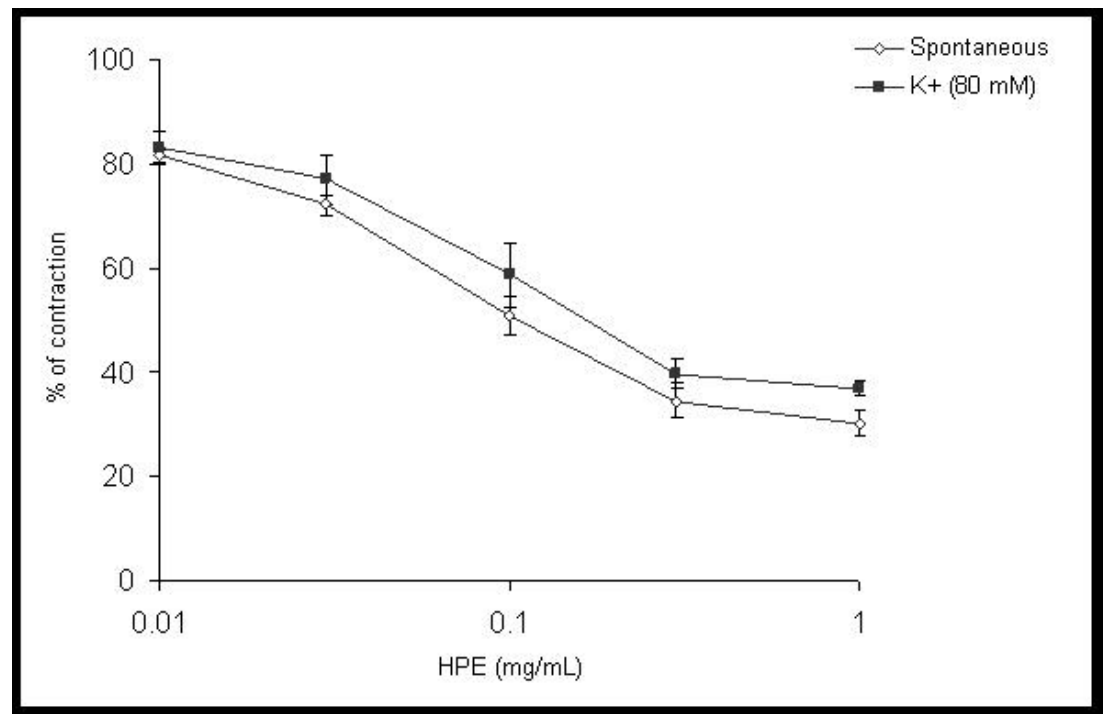
Figure 1. Inhibitory effect of the ethanol extract of Helichrysum plicatum (HPE) on spontaneous and high K + -induced contractions in isolated rat ileum.